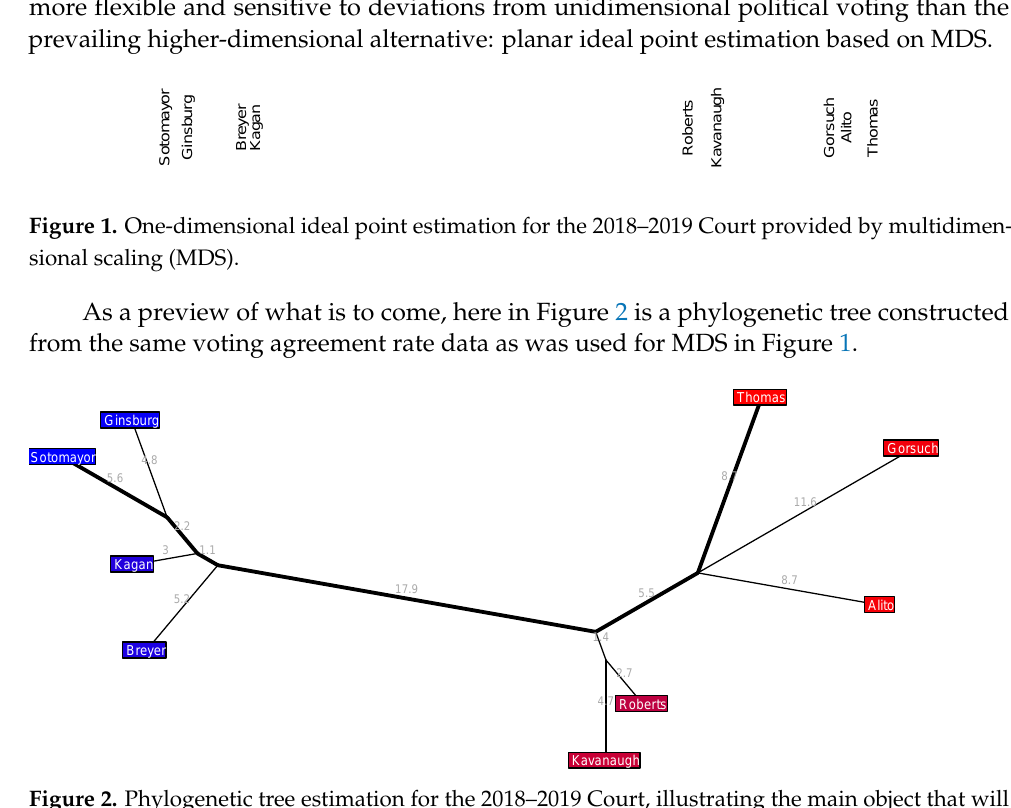
Figure 2. Phylogenetic tree estimation for the 2018–2019 Court, illustrating the main object that will be introduced and studied in this